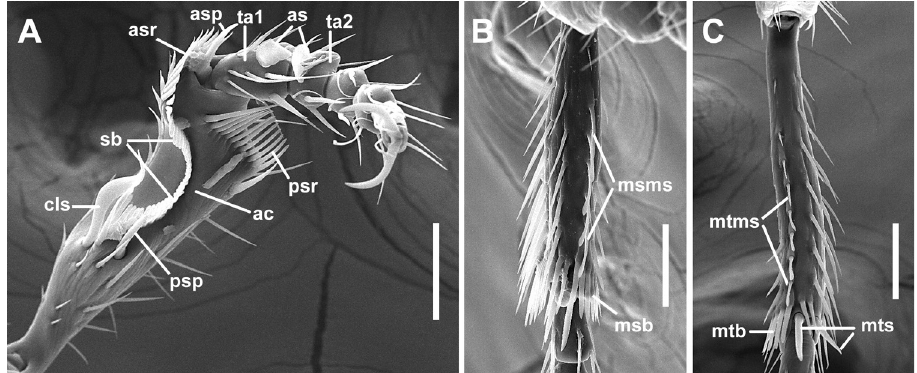
Figure 5. SEM illustrations of structural features of legs of Pelodiaetus sulcatipennis , ventral aspects. A left protarsus and protibia B right mesotibia C left metatibia. Abbreviations: ac – antenna cleaner; as – adhesive setae; asp – anterior spur; asr – anterior setal row; cls – clip seta; msb – mesotibial brush; msms – mesotibial modified seta; mtb – metatibial brush; mtms – metatibial modified seta; mts – metatibial spur; psp – posterior spur; psr – posterior setal row; sb – setal band; ta1–ta2 – tarsomeres 1–2. Scale bars: 0.05